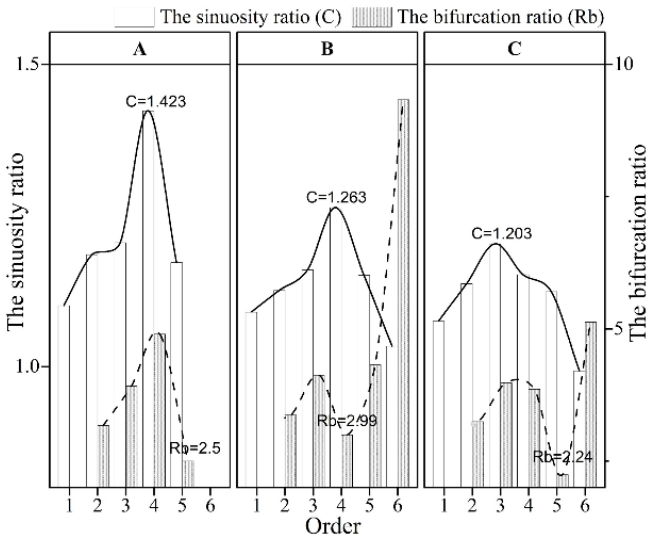
Figure 9. Statistics of ( a ) density and frequency of tidal creeks of different orders and ( b ) total den- sity of tidal creeks in the coastal wetlands of the Liao River Estuary. (A: the supratidal zone; B: the upper intertidal zone; C: the middle intertidal zone.).